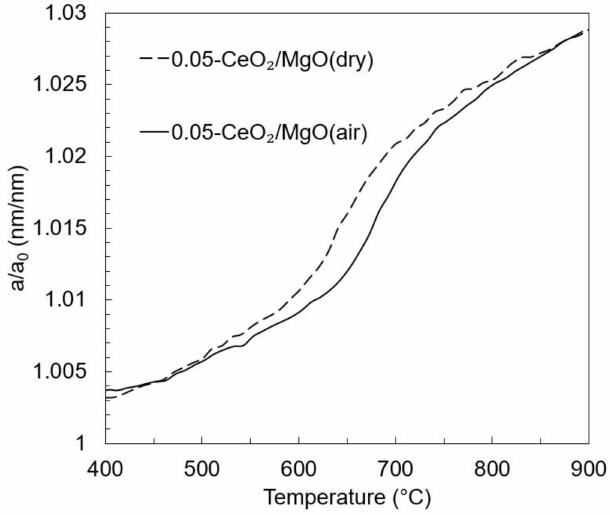
Figure 8. Unit cell parameter a 0 of CeO 2 nanoparticles of 0.05-CeO 2 /MgO(air) and 0.05- CeO 2 /MgO(dry) calculated from in situ XRD measurement. The vertical axis is normalized by the value of a 0 at 200 ◦